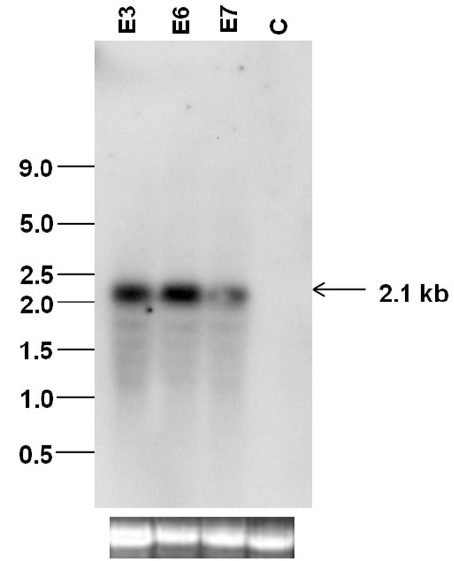
Figure 4. Northern blot analysis of the virE2 transgenic plants (E3, E6, E7) with the virE2 probe. Total RNA from untransformed Nicotiana benthamiana was used as the negative control (C). The bottom panel represents equal loading of RNA (10 µg) in all lanes. 3.3. SLCMV-Infected N. benthamiana Plants Displayed a Reduction in Viral Disease Symptoms